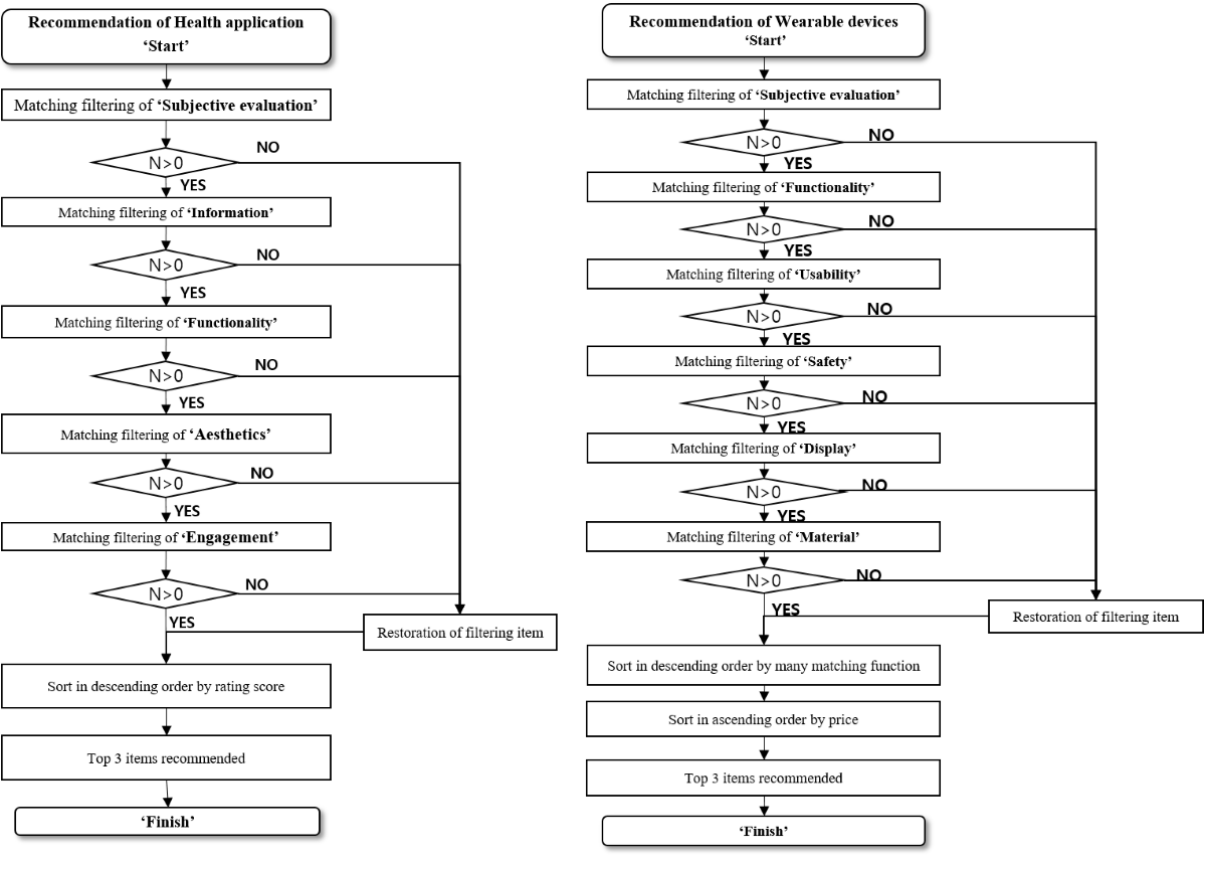
Figure 6. Recommended algorithm of e-Motivate4Change